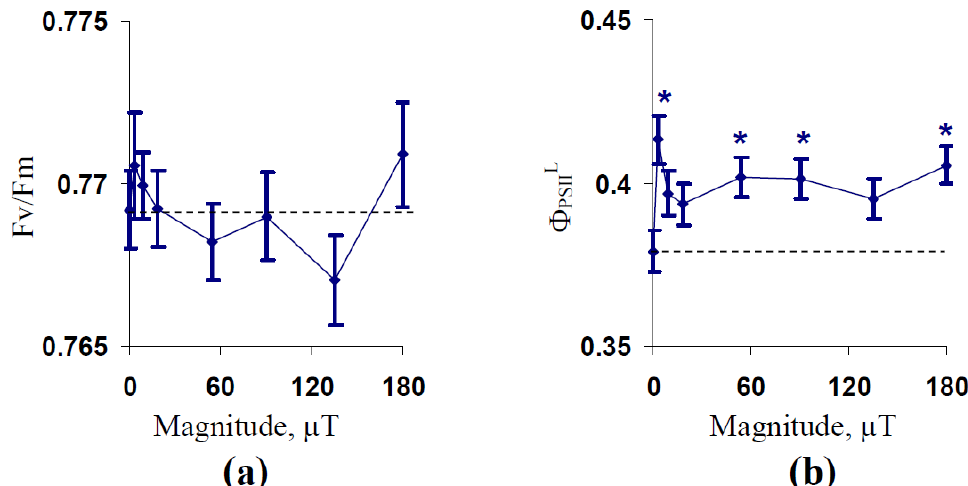
Figure 1. Dependencies of potential quantum yield of PSII (F v /F m ) ( a ) and its effective quantum yield under illumination ( Φ PSIIL ) ( b ) on the magnitude of extremely low-frequency magnetic field (ELFMF) with 14.3 Hz frequency in wheat seedlings ( n = 20–30). The action of the artificial ELFMF was initiated before the dark adaptation; the 30 min treatment was used. Photosynthetic parameters were measured under the treatment. Control seedlings were not treated by the ELFMF (dotted line marked the photosynthetic parameters in these seedlings). *, the difference between photosynthetic parameters in the experimental and control wheat seedlings was significant ( p < 0.05).